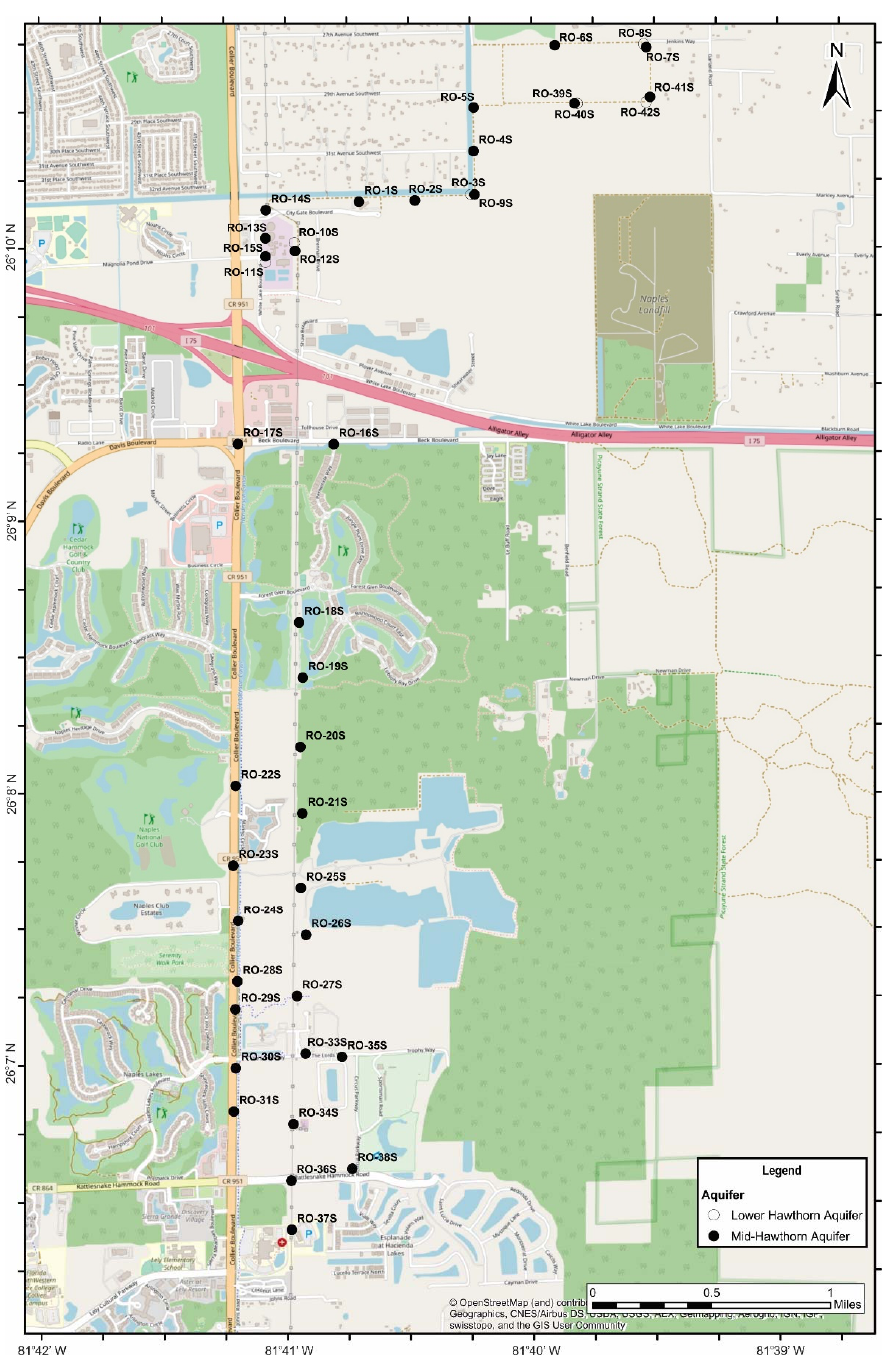
Figure 4. Map showing the location of production wells.